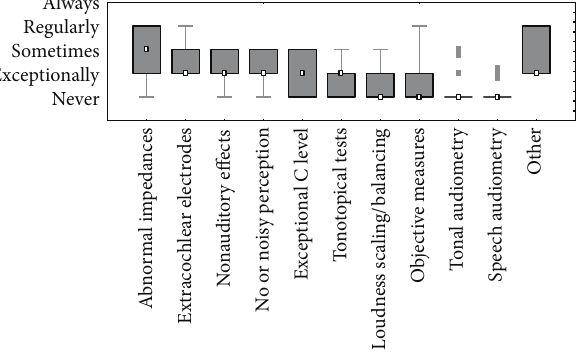
Figure 3: Alleged reasons for deactivating electrodes and the frequency they are reported to be really responsible for electrode deactivation in daily